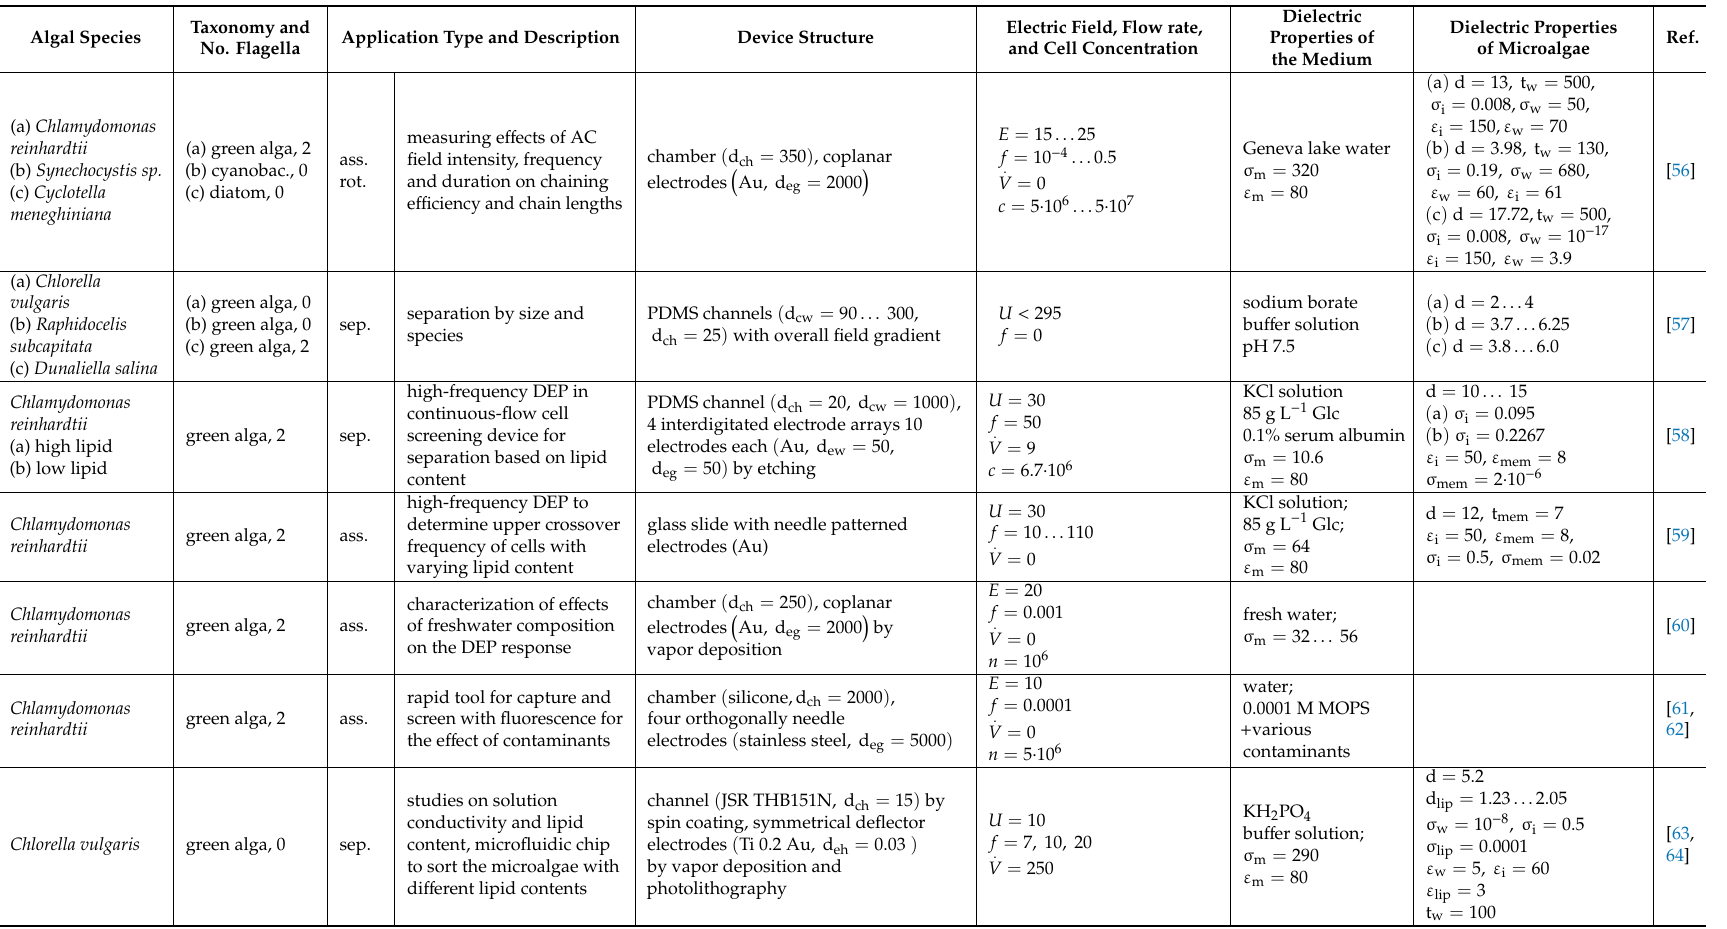
Table 1. Key publications reviewed in this article, with a summary of key features and